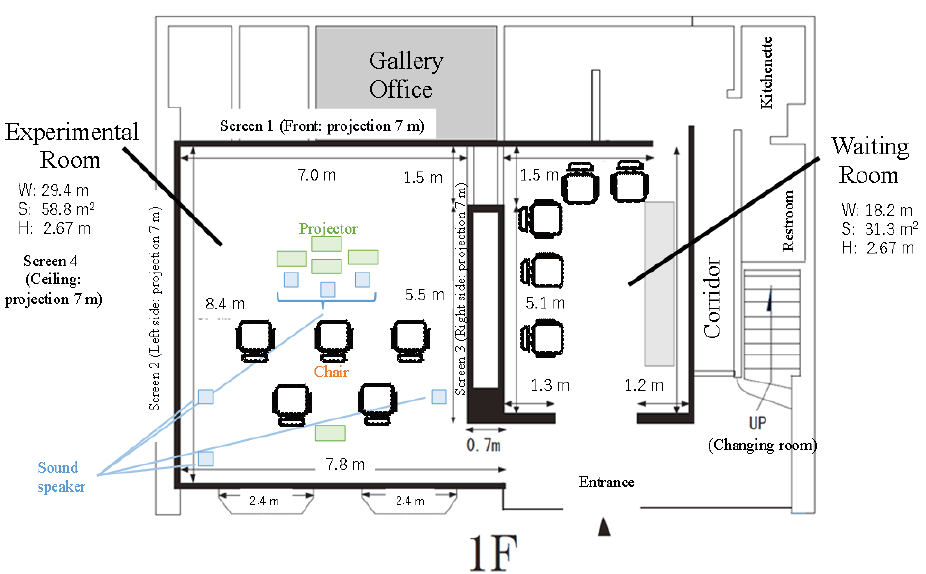
Figure 2. Layout of the experimental and waiting rooms.